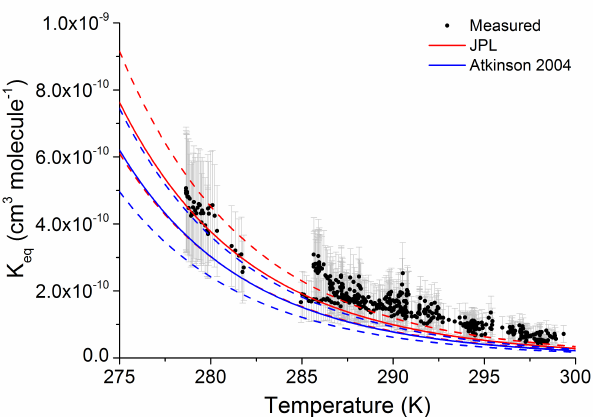
Figure 11. Equilibrium constant ( K eq ) for the reaction NO 2 + NO 3 = N 2 O 5 calculated from measurement of each trace gas (black points, with grey bars representing total uncertainty). The solid lines are values of K eq recommended by the JPL evaluation panel (red line; Burkholder et al., 2016) and IUPAC evaluation committee (blue line; Atkinson et al., 2004). The dashed lines represent the minimum and maximum values according to the